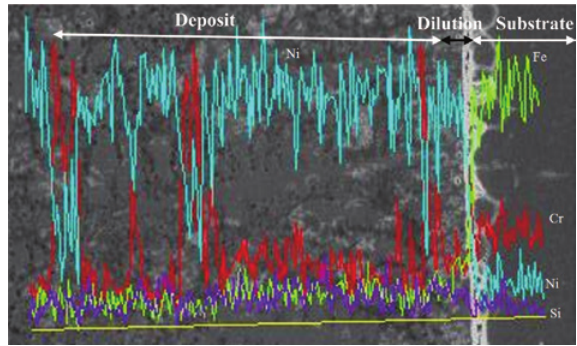
Figure 8: EDS line scan of the constituent elements across sub- strate/deposit interface (optimized